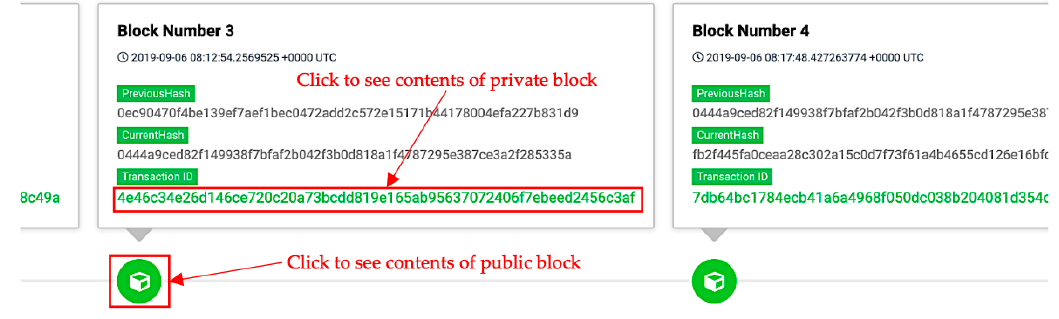
Figure 16. Private blocks within the Figure 3. This is a figure.